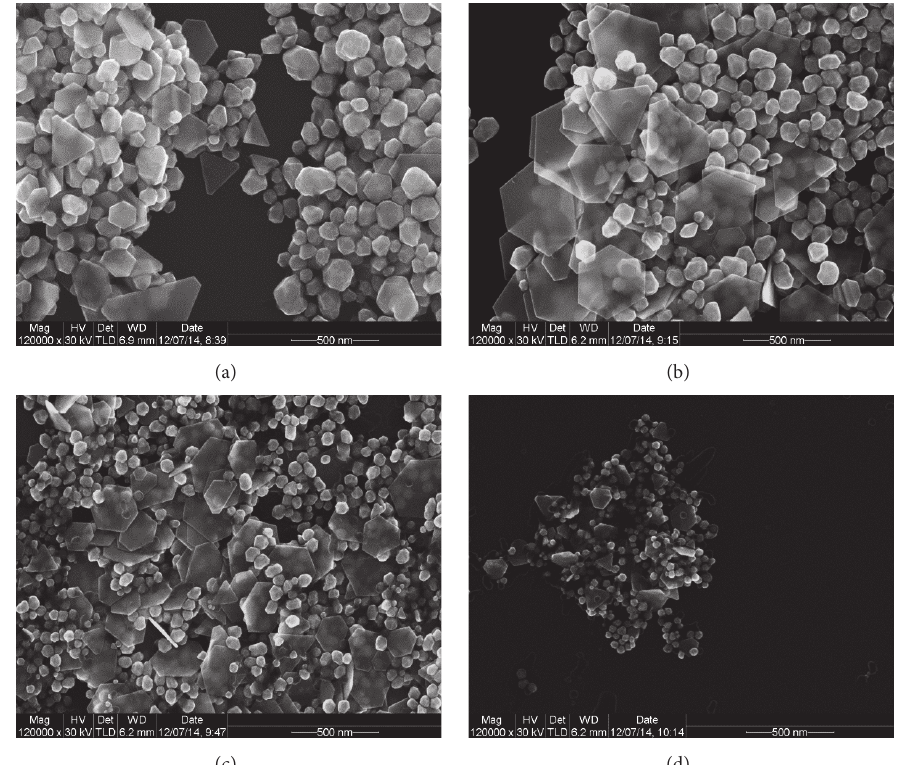
Figure 5: SEM images showing results from gold nanoparticle synthesis with variances in concentration of HAuCl 4 . (a) 0.40 mM, (b) 0.30 mM, (c) 0.25 mM, and (d) 0.20 mM.